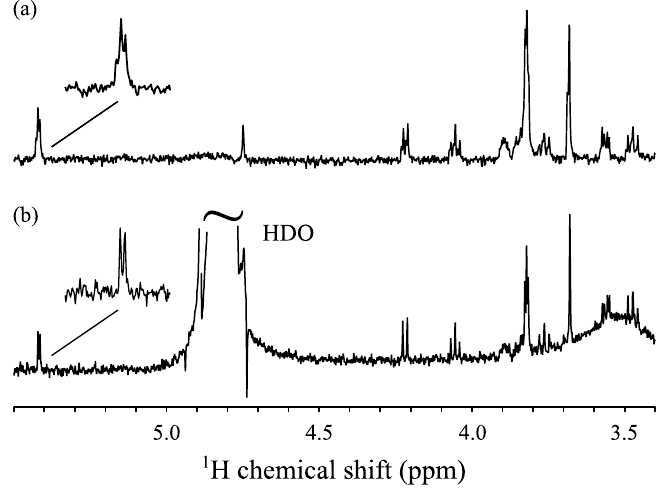
Figure 2. The 1D proton spectra of 0.25 µg sucrose recorded by 1 H single pulse HRµMAS probe using a capillary-insert ( a ) and by solution NMR using a conventional 5 mm tube ( b ). 1024 scans were collected. Each experiment took for 1.5 h.